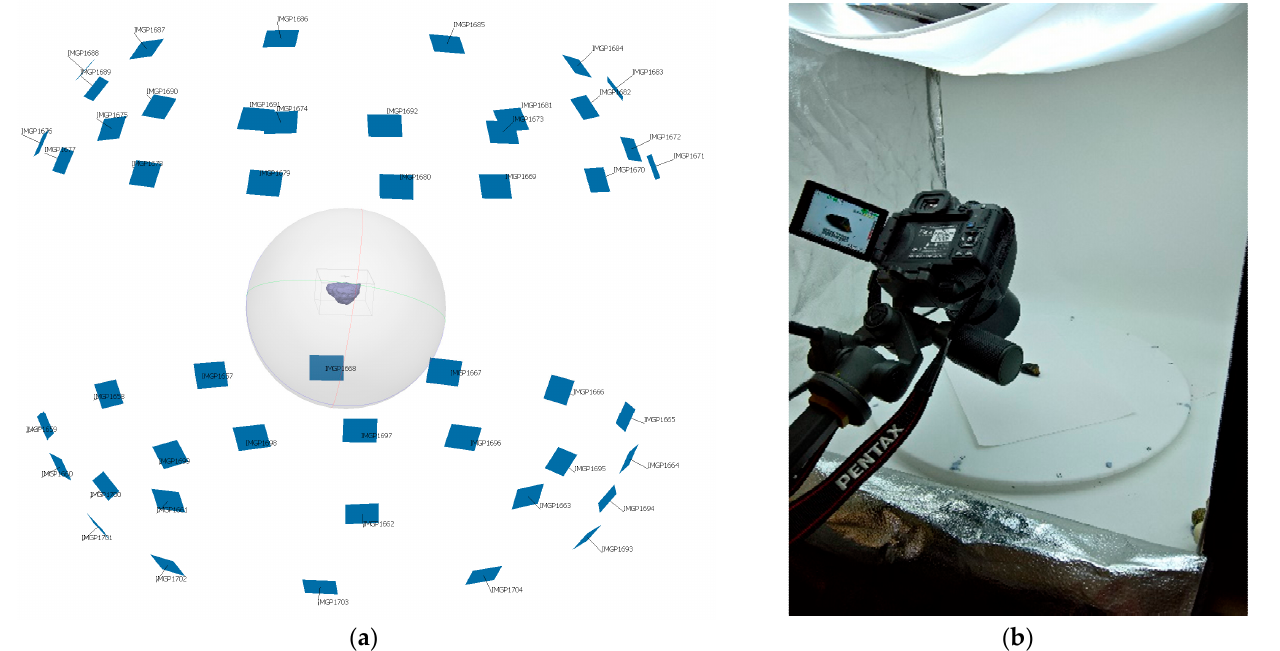
Figure 2. ( a ) Screen capture from AGI Soft Metashape, ( b ) turntable setup.